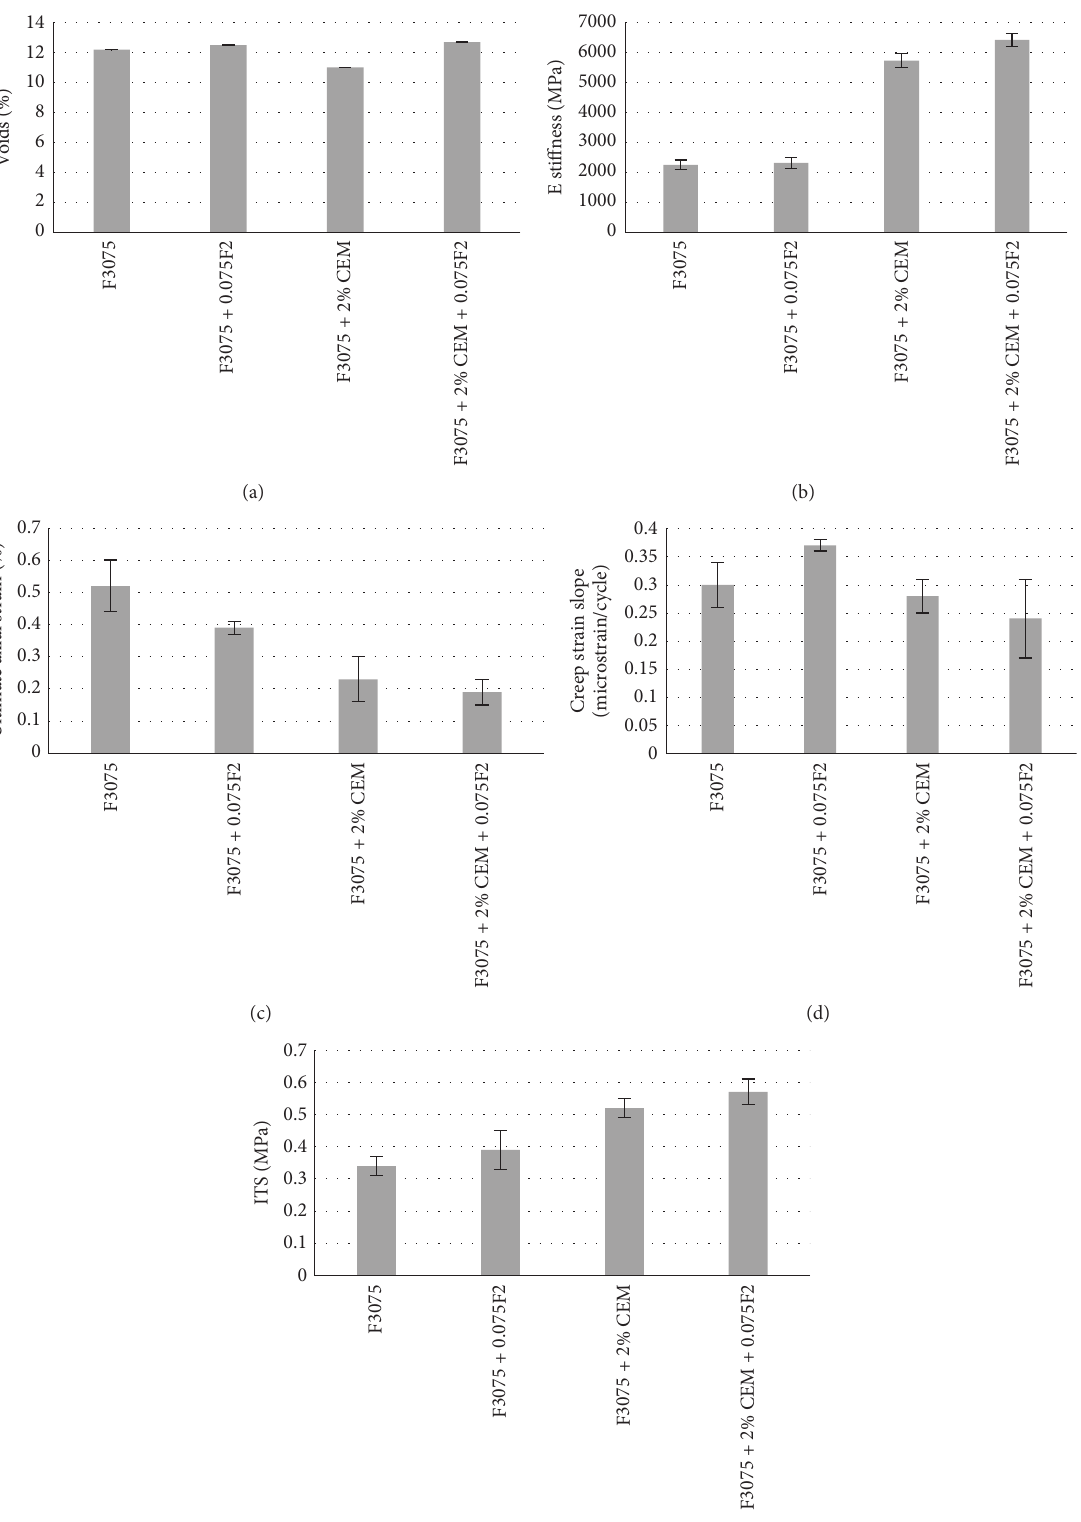
Figure 6: Effect of cement on (a) voids, (b) stiffness, (c) UAS, (d) CSS, and (e) ITS. E: Stiffness